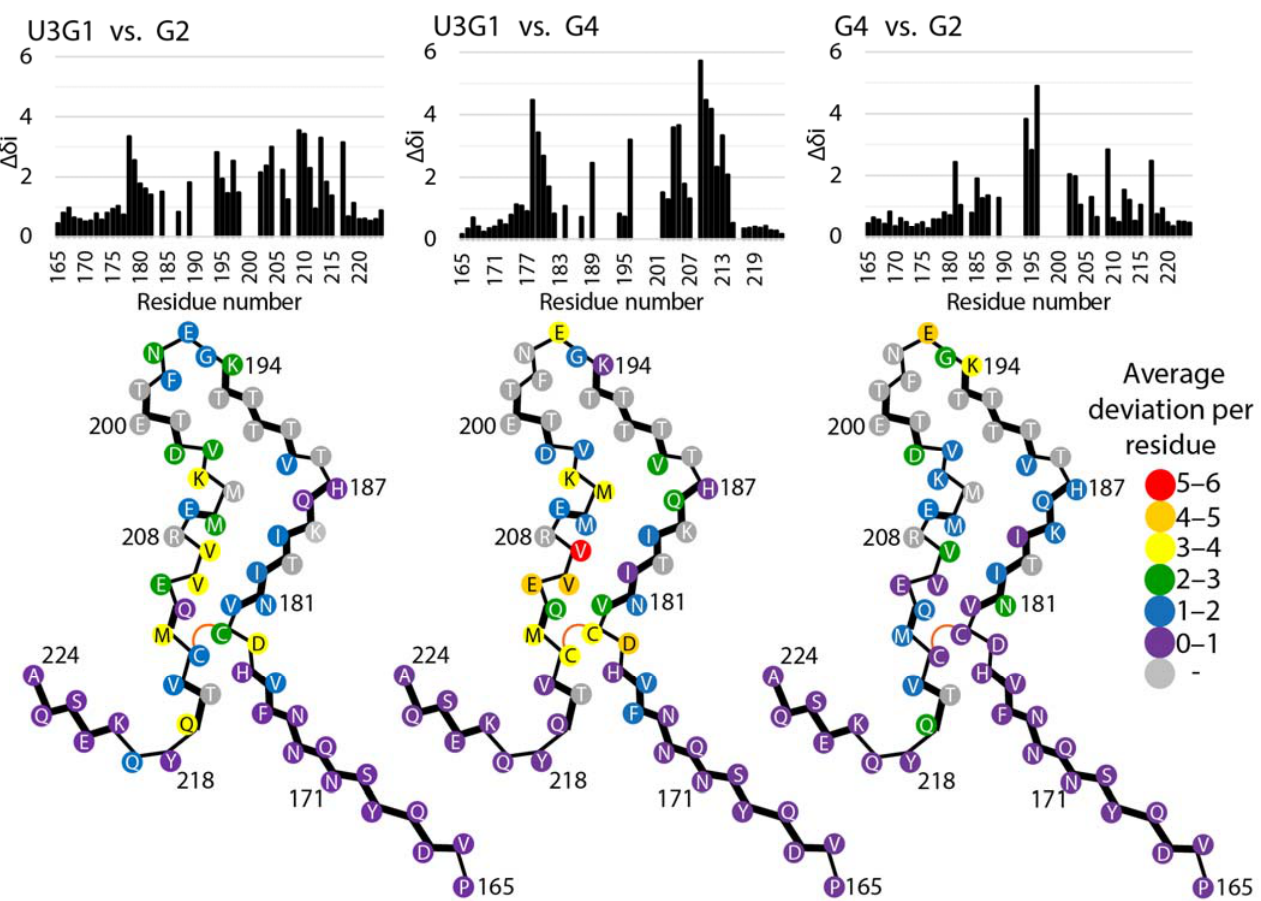
Figure 4. Residue-averaged 13 C, 15 N chemical shift differences between MoPrP(89-230) U3G1, G2 and G4 condition fibrils. Top panel: histograms of the chemical shift differences vs. residue number. Bottom panel: structural model of U3G1 fibrils color-coded to reflect the chemical shift differences between U3G1 and G2, U3G1 and G4, G2 and G4 condition fibrils. Beta strands are indicated by bold lines.